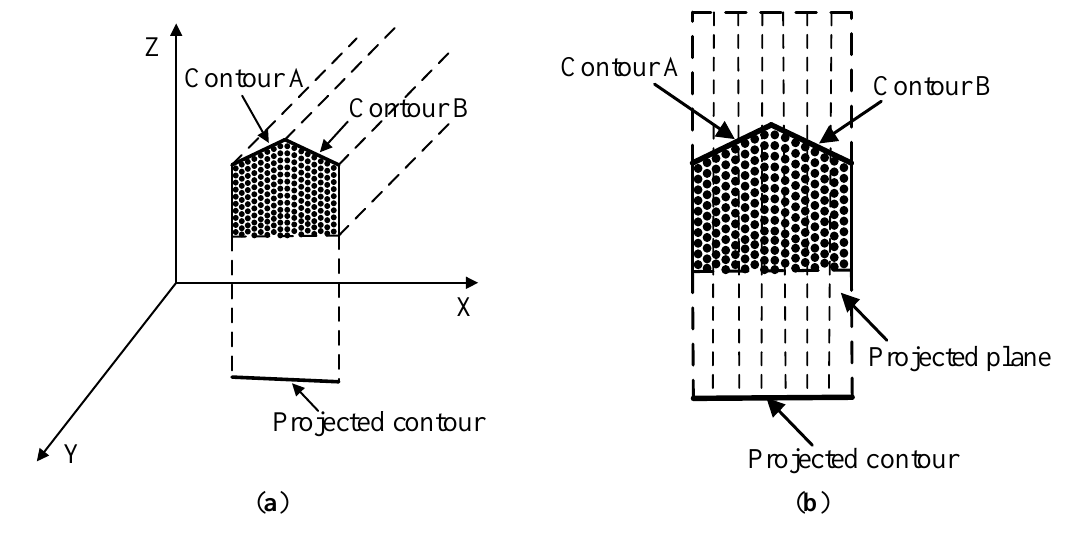
Figure 5. Contour segmentation using point elevation. ( a ) A sample of a projected 2D contour; ( b ) A sample of 3D contour